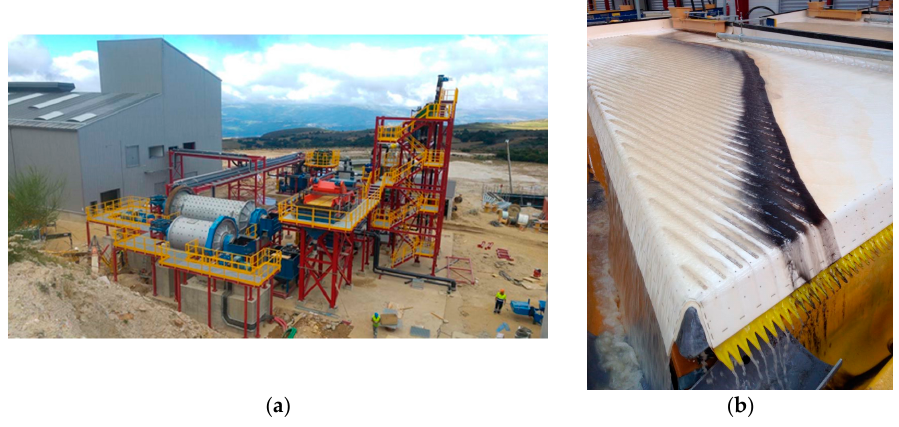
Figure 1. Milling facility ( a ) and shaking table ( b ) for concentrating the Sn–Nb–Ta mineral.